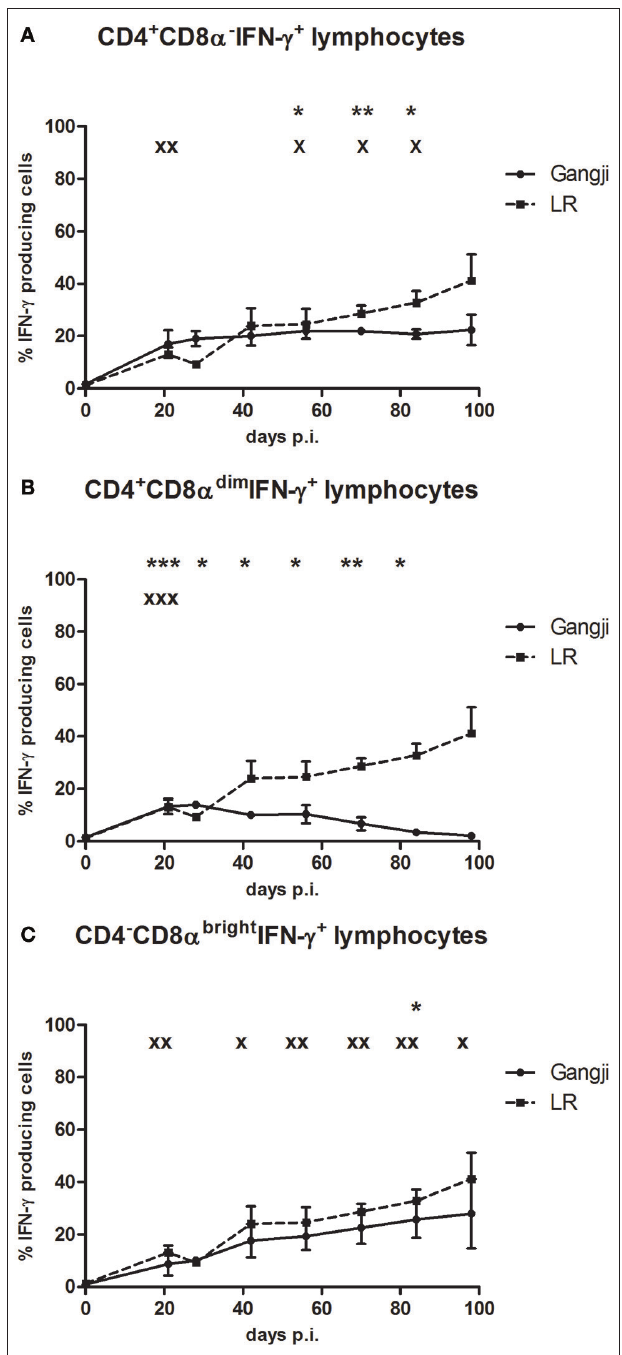
FIGURE 8 | The percentage of IFN- γ + T lymphocyte subsets in PBMCs after a single IPB-G or IPB-LR inoculation. IFN- γ + T lymphocyte subsets in PBMC’s of pigs after oral infection with a high dose of the IPB-G (G high ) or the IPB-LR strain (LR high ). Cells were restimulated in vitro with TLA and demonstrated by flow cytometry following triple staining for IFN- γ , CD3, CD4, and CD8 (A) . IFN- γ + cell populations were identified as (A) CD3 + CD4 + CD8 α − IFN- γ + , (B) CD3 + CD4 + CD8 α dim IFN- γ + , (C) CD3 + CD4 − CD8 bright IFN- γ + lymphocytes. The results represent mean percentages ± SD for each group; * (IPB-G) or x (IPB-LR): P < 0.05, ** or xx: P < 0.01; *** or xxx: P < 0.001 in comparison with day